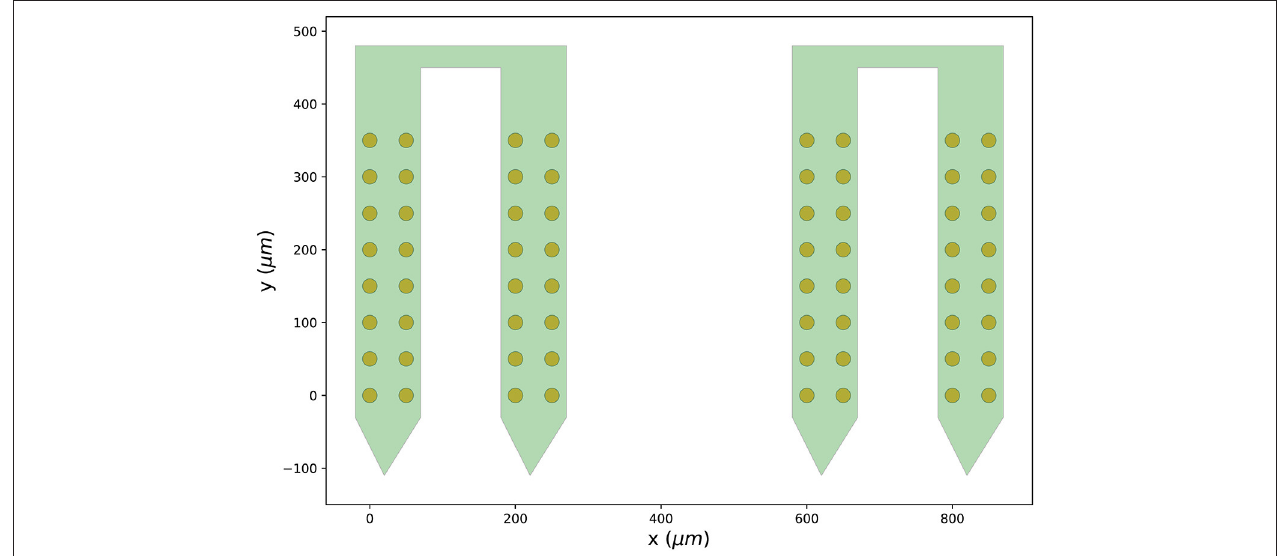
FIGURE 3 | Probes downloaded from the probe library. Visualization of the probe group created in Section 3.2 including a Cambridge Neurotech probe (ASSY-156-P-1 – left) and a NeuroNexus device (A1x32-Poly3-10mm-50-177 – right).